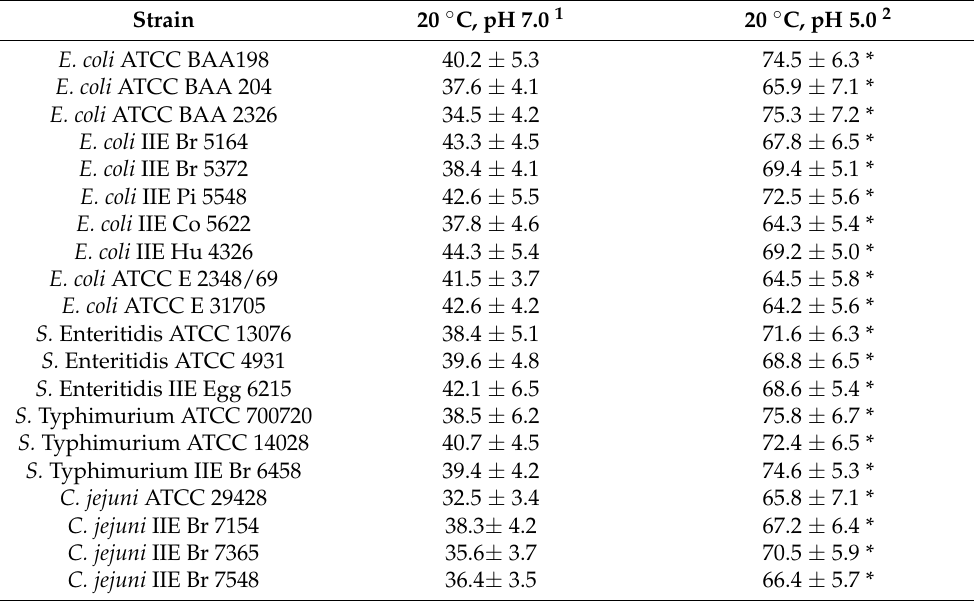
Table 7. Co-aggregative abilities of LF3872 strain with proteobacteria